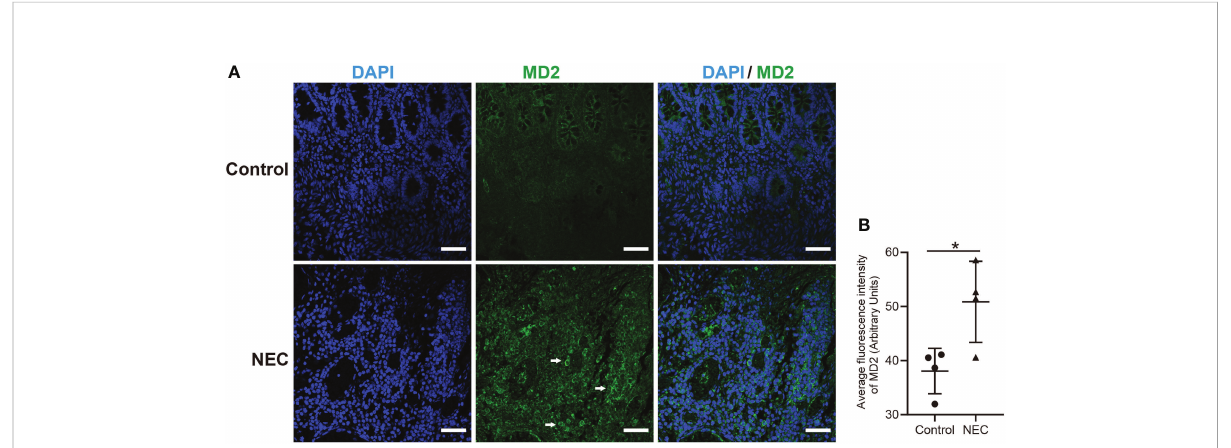
FIGURE 1 Clinical characteristics and MD2 expression levels in intestinal tissues of NEC patients. (A) MD2 expression in intestinal tissue of patients. MD2 (green) and DAPI staining of nuclei (blue) in intestinal tissue of the control and NEC groups. Scale bar, 50 m m. (B) Average fl uorescence intensity of MD2. Data are presented as the mean ± SD (n=4). The scatter plots represent the mean value of the average intensity of fl uorescence in 6 random fi elds in each section of the quanti fi cation diagram. *p value <0.05 for each group comparison using a two-tailed Student ’ s t